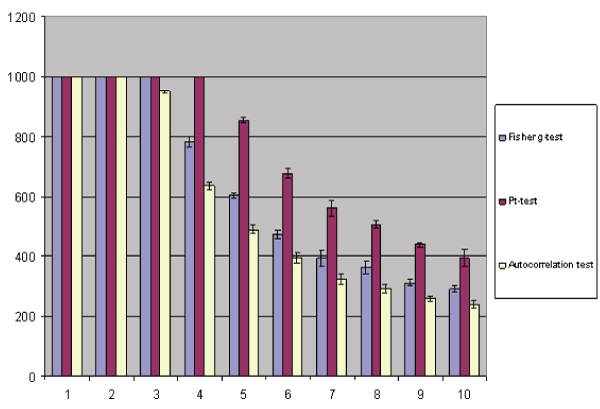
Result of analysis of an artificial data set. With increase of stochastic noise all three algorithms recognize fewer oscillating profiles. However in each category permutation test consistently report oscillation in more profiles than the other two algorithms. Bars delimit standard deviation of mean number of identified oscillating profiles based on 5 repeated simulations.